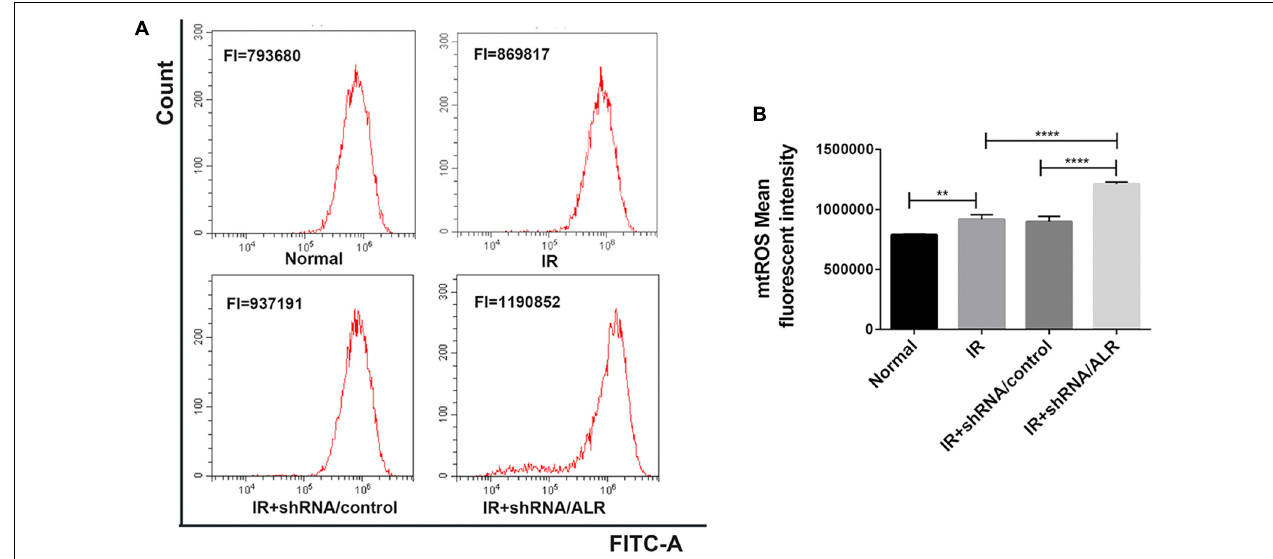
FIGURE 7 | Silencing of augmenter of liver regeneration (ALR) enhanced ischemia–reperfusion (I/R)-induced mitochondrial reactive oxygen species (ROS) generation. (A) The levels of mitochondrial ROS were determined by flow cytometry. (B) Quantitation of MitoSOX were shown in a bar graph. Data represent means ± SD. n = 3. ** p < 0.01, **** p <